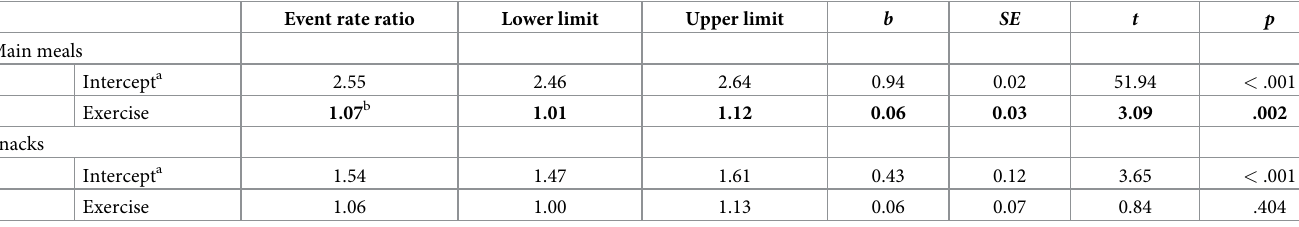
above the other predictors. Table 3. Exercise as predictor of number of main meals and snacks consumed (Study